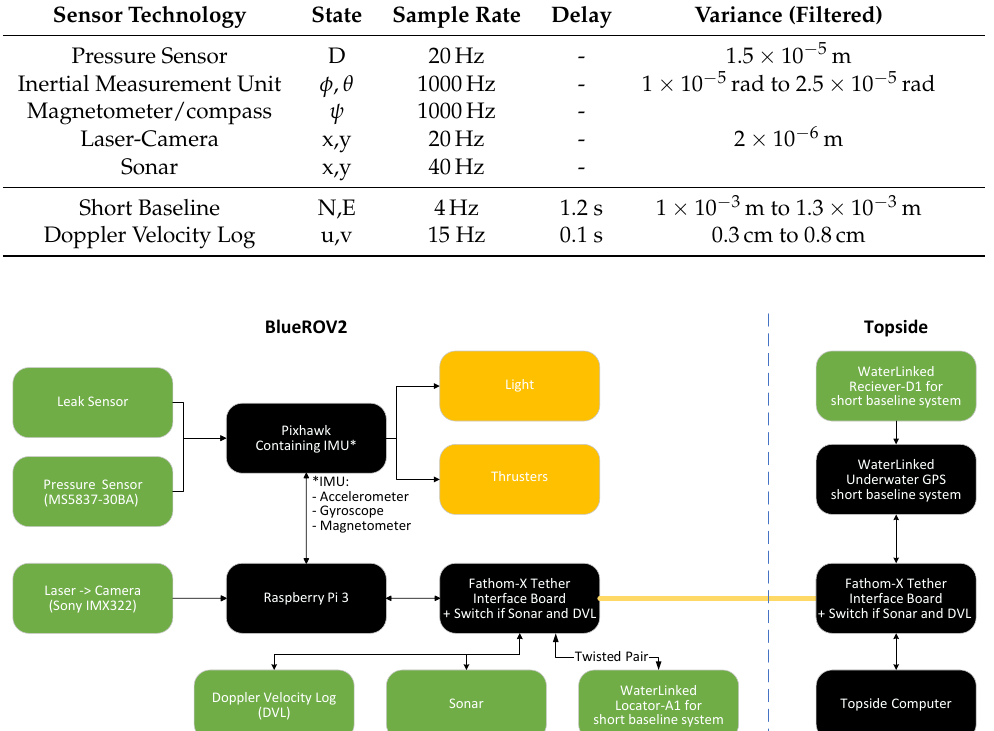
Figure 1. Hardware and interfaces on BlueROV2, green boxes represents sensors, black boxes represents processing units/control units, the yellows boxes represents actuators, and the dashed blue line illustrates the cut between onboard hardware and topside hardware.